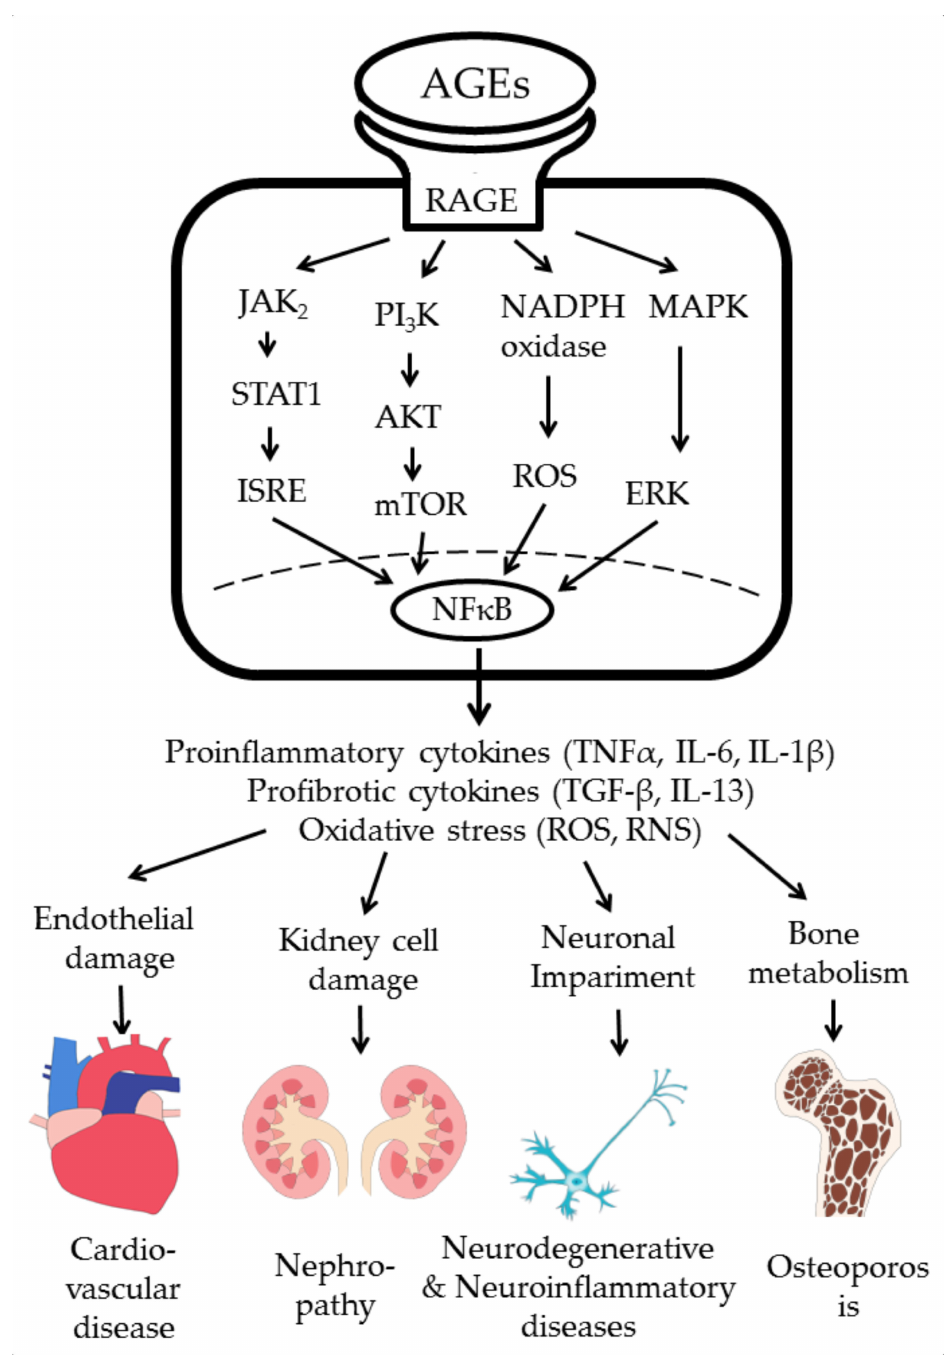
Figure 2. AGE–RAGE interaction in immune-related cells transduces signals for gene expressions of proinflammatory and profibrotic cytokines, and increased oxidative stress to induce cell and tissue damage. ISRE: interferon stimulated response element; ROS: reactive oxygen species; RNI: reactive nitrogen